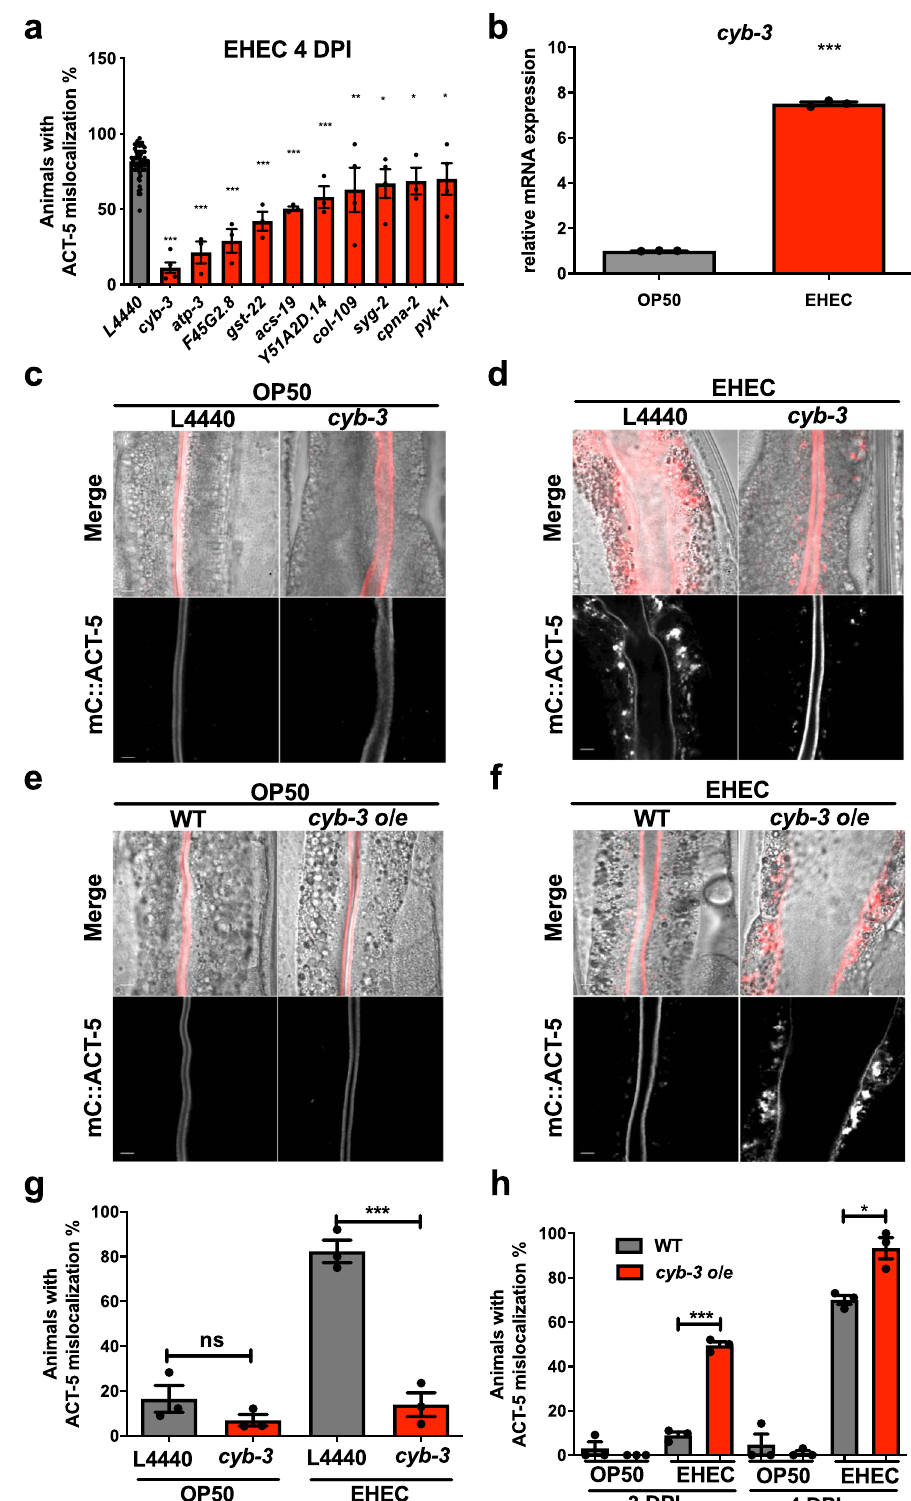
strain JNC100 21 ) into the mC::ACT-5 background. As shown in Fig. 2e, we did not observe ACT-5 mislocalization in the cyb-3 o/e animals fed with OP50 for 3 days. However, cyb-3 o/e animals infected with EHEC for 3 days exhibited early onset of the ACT-5 mislocalization phenotype compared to the WT worms (Fig. 2f). The quanti fi cation results are shown in Fig. 2h. cyb-3 o/e worms fed with EHEC for 3 or 4 days all showed a signi fi cant increase of NATURE COMMUNICATIONS| (2021) 12:90